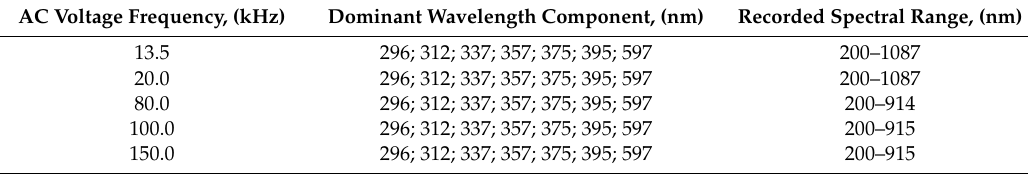
Figure 2. Optical spectra recorded for the electric arc generated at alternating voltage U = 5.0 kV at generation voltage frequency: f = 13.5 kHz ( a ); f = 20.0 kHz ( b ); f = 80.0 kHz ( c ); f = 100.0 kHz ( d ); f = 150.0 kHz ( e ). Table 1. The dominant wavelength component for recorded optical spectra.